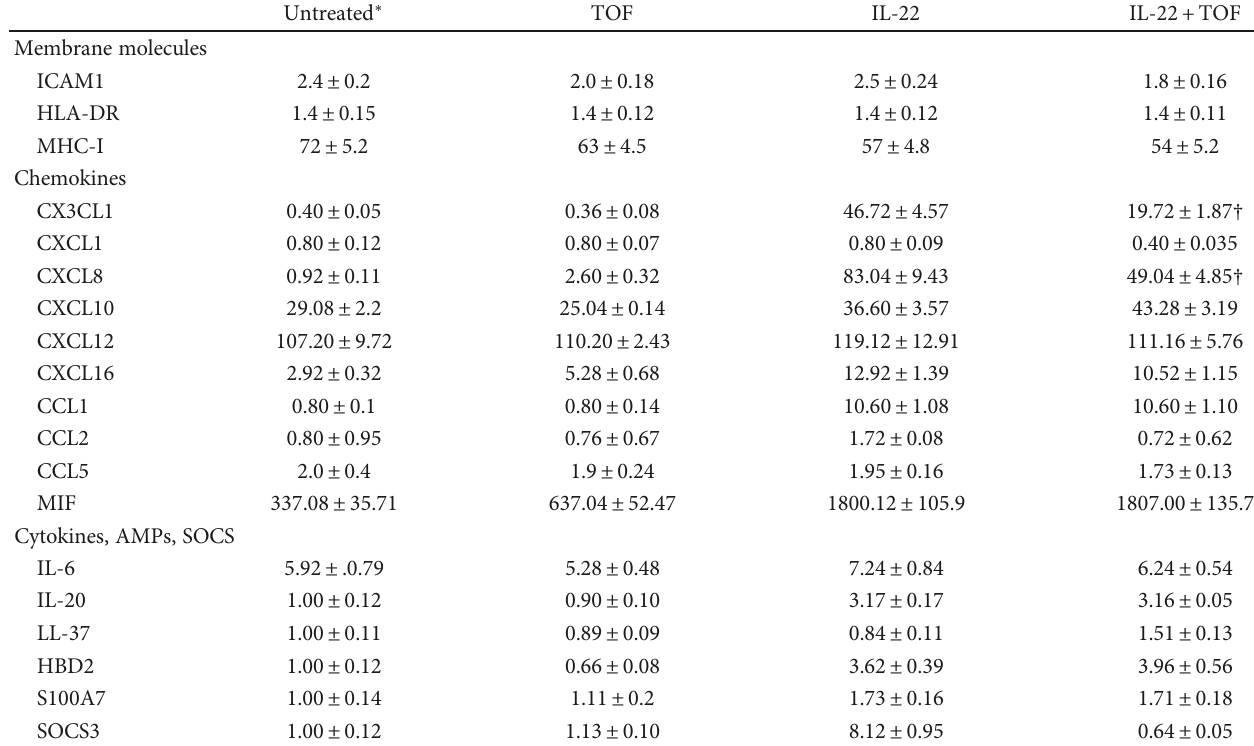
Table 2: Tofacitinib e ff ects on the expression of in fl ammatory molecules induced by IL-22 in keratinocytes. Untreated ∗